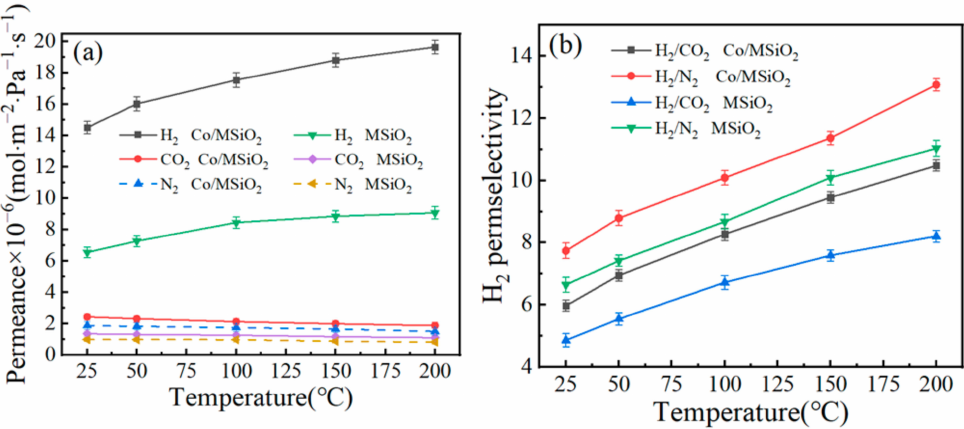
Figure 9. Influence of temperature on the ( a ) gases’ (H 2 , CO 2 , and N 2 ) permeances and ( b ) H 2 perm-selectivities for supported MSiO 2 membrane and supported Co/MSiO 2 membrane with n Co = 0.08 at 0.2